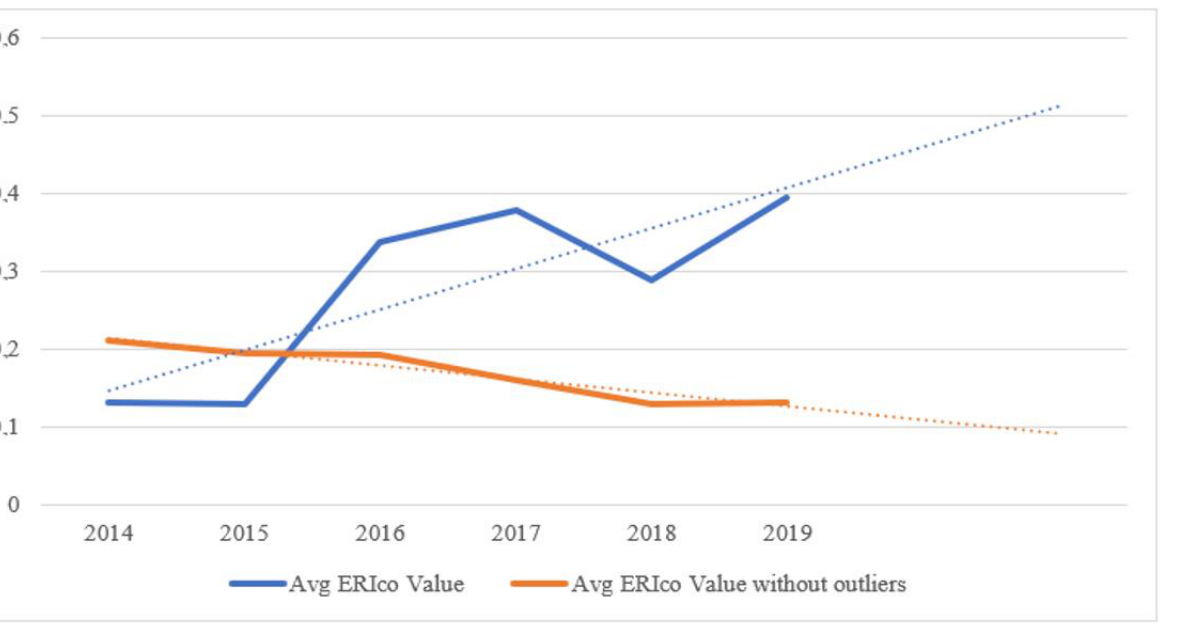
Figure 4. Forecast of ERI CO of actual values and ERI CO after exclusion of outliers. Own processing. To evaluate the H2 hypothesis, it is necessary to recalculate the amount of emissions produced to the relevant financial